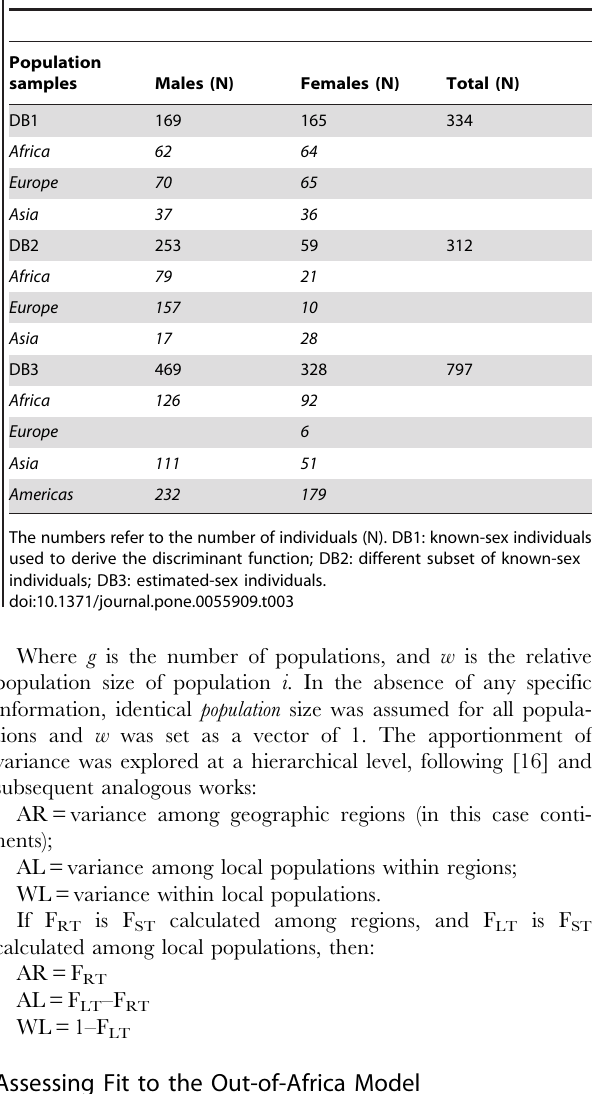
Table 3. Subsets of the original dataset used to test the accuracy of visual sex